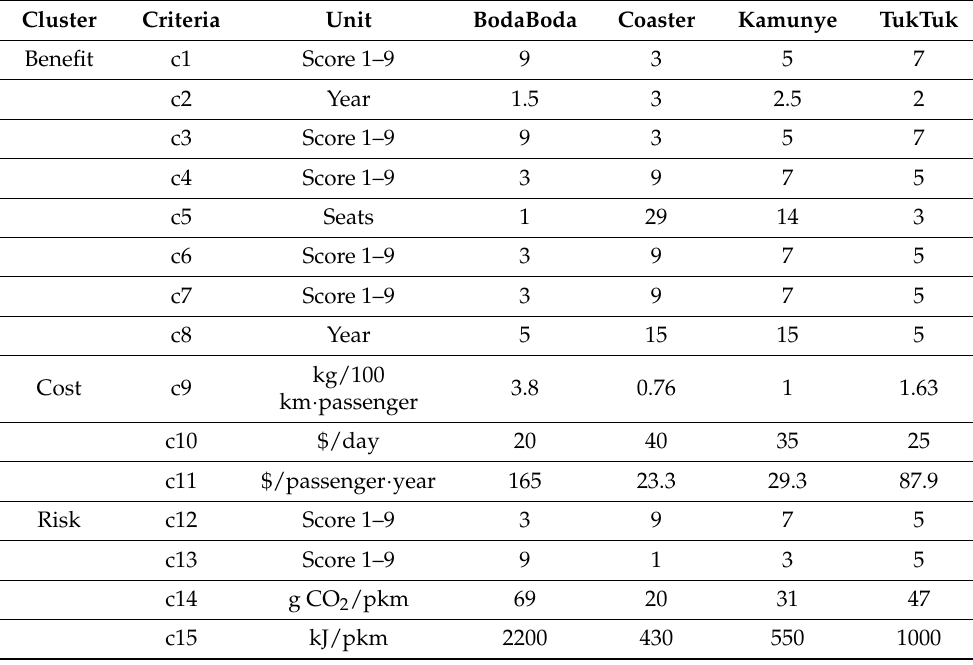
Table 2. Original MIS adopted from Kalifa et al.